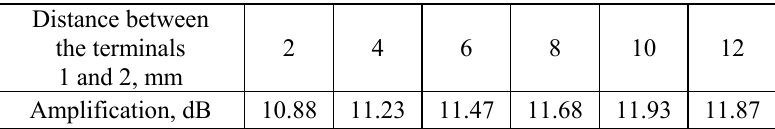
Table 2. The dependence of the gain on the distance between the terminals 1 and 2 of the microstrip